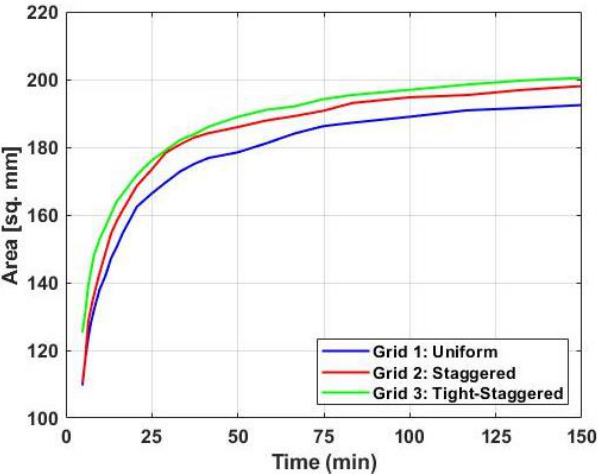
Figure 13. Graph showing the area covered by the droplets using all three grids.